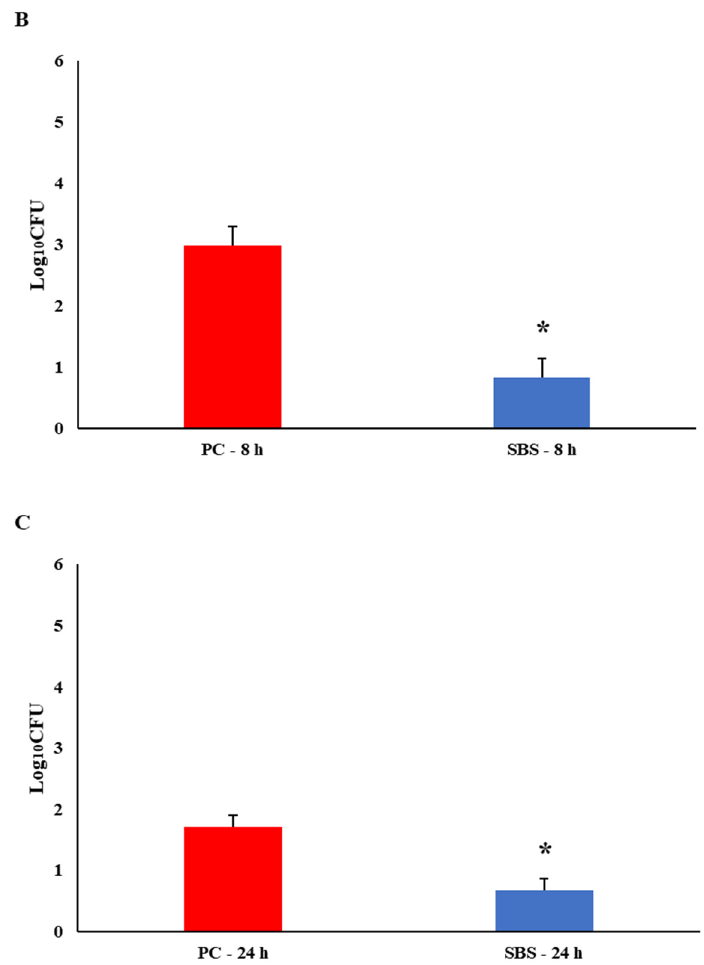
Figure 1. Salmonella Heidelberg biofilm on PVC coupons ( n = 18/treatment) were significantly reduced by sodium bisulfate (SBS) at a pH of 3.5 ( p < 0.05) * when treated for 8 h or 24 h. The positive control was tap water. Values presented are the averages of 6 separate experiments with triplicate coupon samples within each experiment. Coupons were treated for ( A ) 10 min, ( B ) 8 h, or ( C ) 24 h.